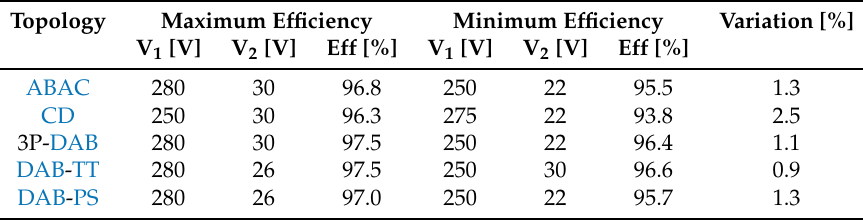
Table 4. Maximum and minimum full power efficiency map values in buck